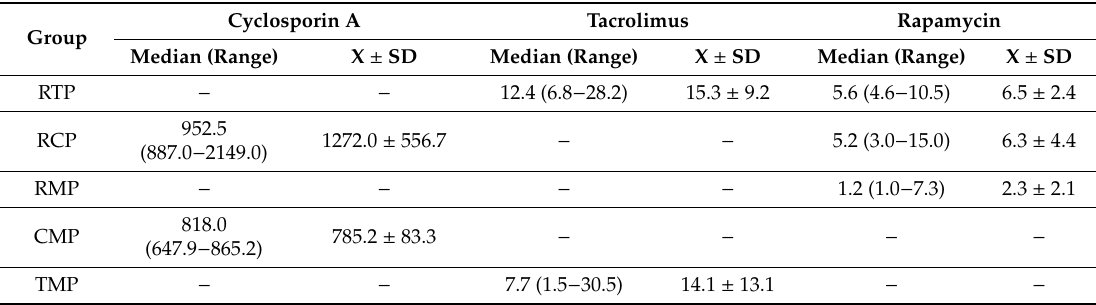
Table 1. Drug concentrations (ng / mL) in the blood of rats in the experimental